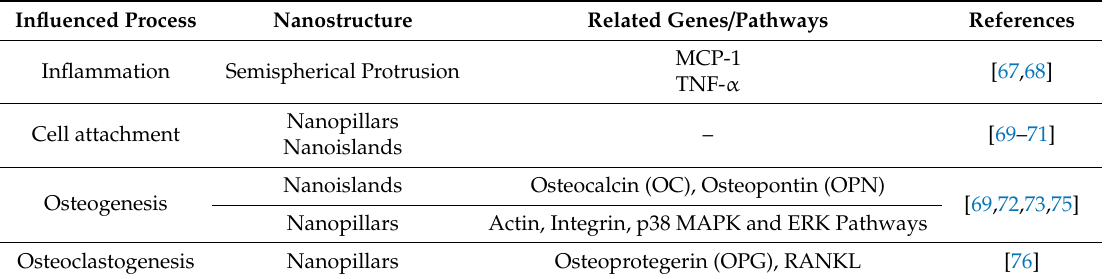
Table 2. Summary of biological processes and molecules a ff ected by